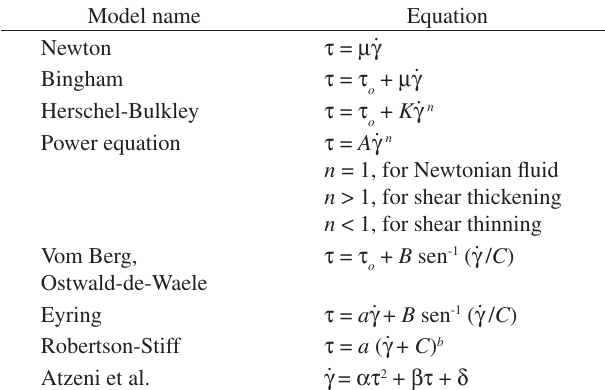
Table 1. Rheological models applied to the fresh concrete 1